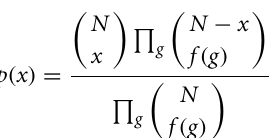
Purple, tumor size; brown, number of metastatic lymph nodes > 3; gray, distant metastasis( + ); green, age over 45 years old; pink, female; pale blue, stage III or IV; red, recurrence ( + ); orange, BRAF mutation( + ); blue, RAS mutation ( + ). The two samples with recurrence (red) had no aberrant methylation ( P = 0.03, Fisher’s exact test). BRAF / RAS oncogene mutations were all observed in methylation( + ) samples ( P = 0.03, Fisher’s exact